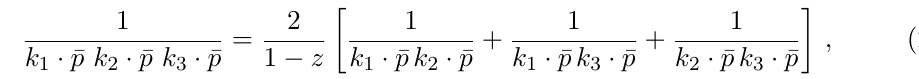
q (cid:3) + q 0 (cid:22) q 0 g for q 0 = q ! 6